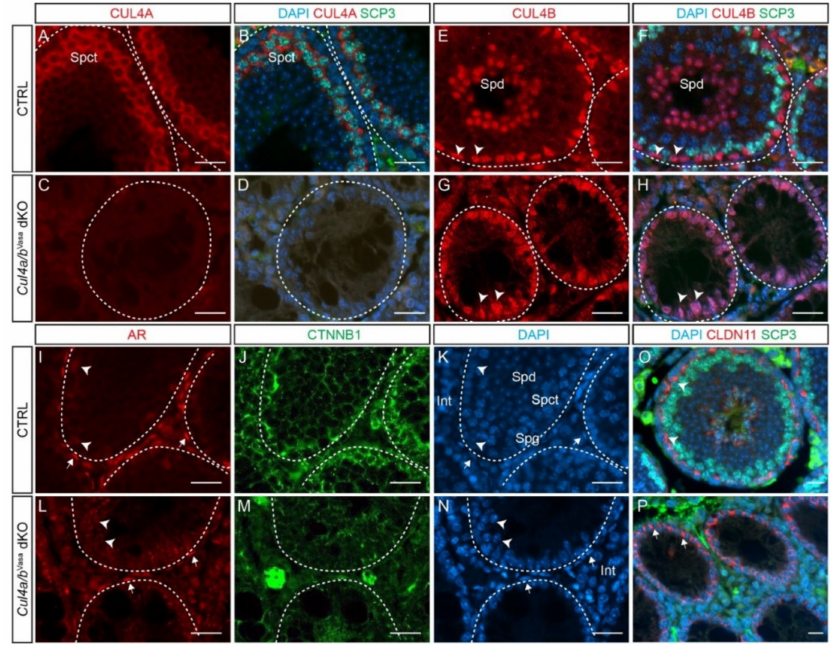
Figure 4. Cul4 genes are required for male germ cell survival. ( A – D ) IF staining of CUL4A (red) and SCP3 (green) of P28 testis. While primary spermatocytes expressing both CUL4A ( A ) and SCP3 ( B ) are present in the CTRL testis, this population is completely missing in the dKO mutant testis ( C , D ). ( E – H ) IF staining of CUL4B (red) and SCP3 (green) of P28 testis. CUL4B is highly expressed in the Sertoli cells ( E , arrowheads) and round spermatids (Spd) of CTRL testis ( E , F ); whereas in the Cul4a/b Vasa dKO, CUL4B-positive Sertoli cells are the only cell type remaining in the seminiferous tubules ( G , H arrowheads). ( I – N ) IF staining of AR (red) and CTNNB1 (green) of P28 testicular sections. Wild-type testis show AR-high myoid cells ( I , arrows) and AR-low Sertoli cells ( I , arrowheads), and well organized germ cell/Sertoli cell network outlined by CTNNB1 staining ( J ). The dKO mutant testis retains myoid and Sertoli cells ( L , arrows and arrowheads, respectively), with disorganized residual CTNNB1 staining ( M ). DAPI counterstain is shown in ( K ) and ( N ). Spd, spermatids; Spct, spermatocytes; Spg, spermatogonia; Int, interstitial cells. ( O , P ) IF staining of CLDN11 (red) and SCP3 (green) of P28 testis. At this stage in the wildtype testis, tight junctions have formed apical to the spermatogonial stem cells to separate the basal and adluminal compartments ( O , arrowheads). CLDN11 was only detected in the basal-lateral membranes of dKO Sertoli cells ( P , arrows). Scale bars: 50 µ